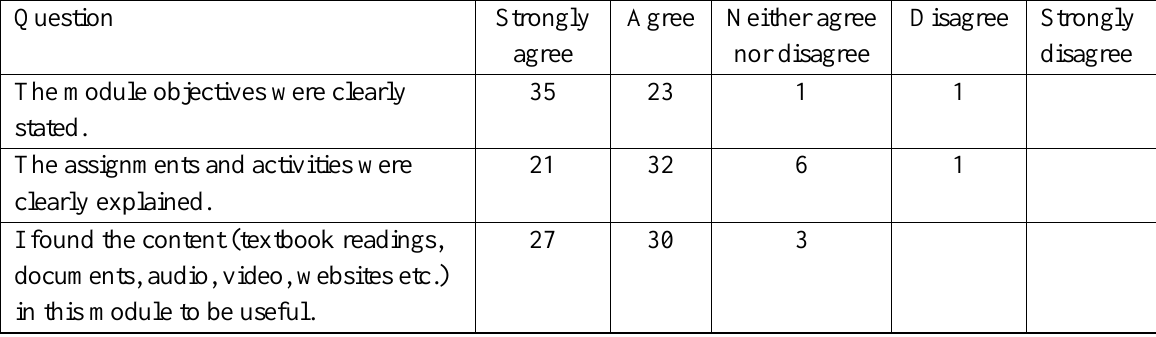
Disagree Strongly